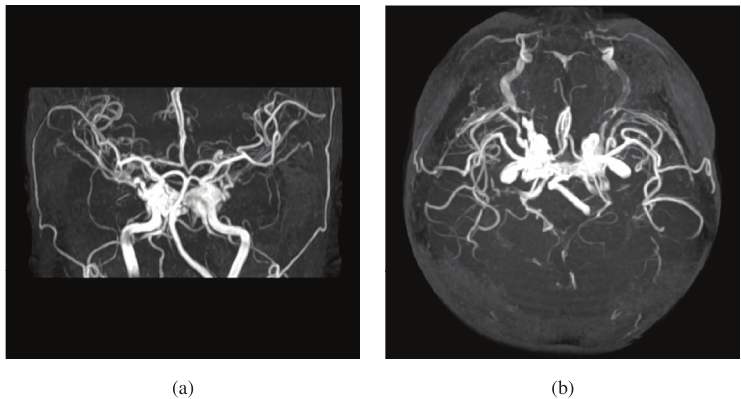
FIGURE 1: The magnetic resonance angiogram (MRA) of the patient showed increased flow related signals around both cavernous sinuses.